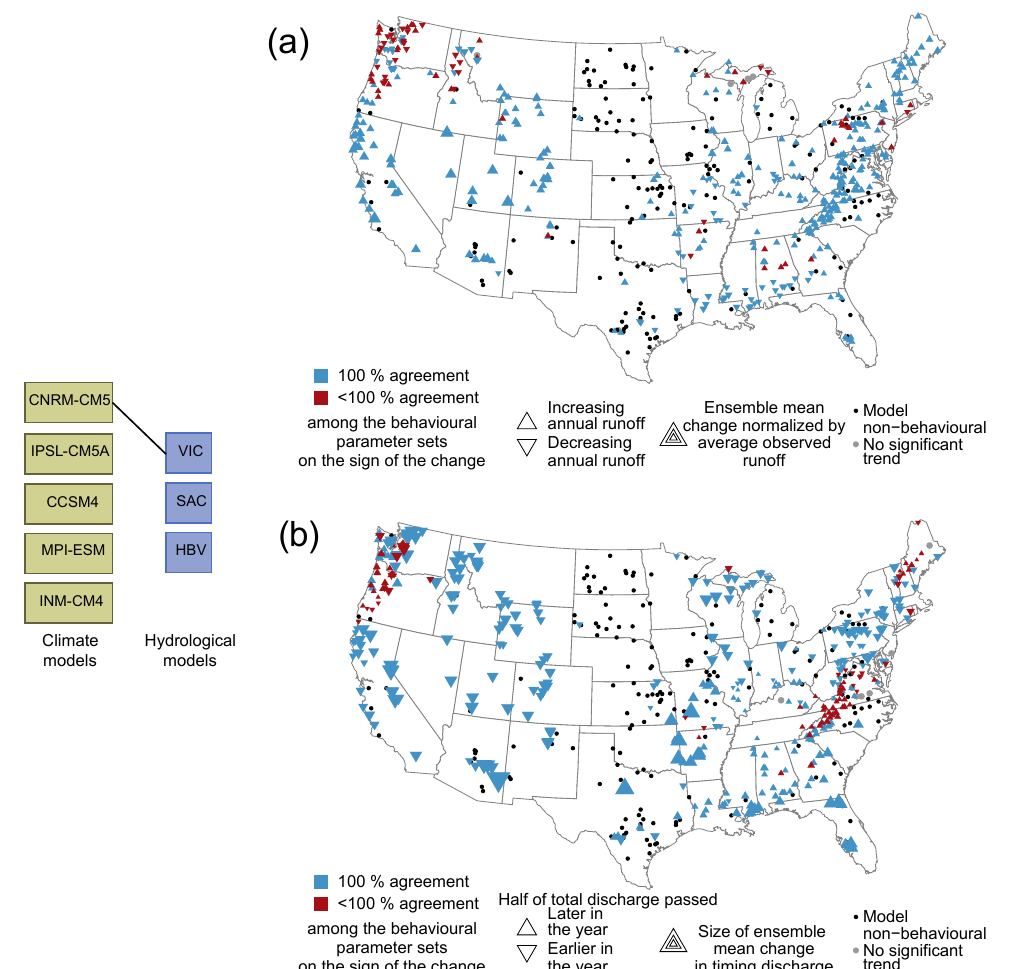
Figure 2. Distribution of uncertainty in the sign of change in mean runoff (a) and discharge timing (b) over the contiguous US when different behavioural parameter sets are compared. Left panel: combination of climate model and hydrologic model for which the results are displayed, in this case, the CNRM-CM5 climate model with the Variable Infiltration Capacity (VIC) hydrological model (SAC: Sacramento Soil Moisture Accounting model; HBV: Hydrologiska Byråns Vattenbalansavdelning model). (a) The agreement among the different model runs (representing different behavioural parameter sets) of the VIC model on the sign of the ensemble mean change in mean annual runoff. (b) The agreement among the different model runs of the VIC model on the sign of the ensemble mean change in discharge timing. The direction of the triangle marker shows the sign of the ensemble mean change; the size of the marker indicates the relative projected